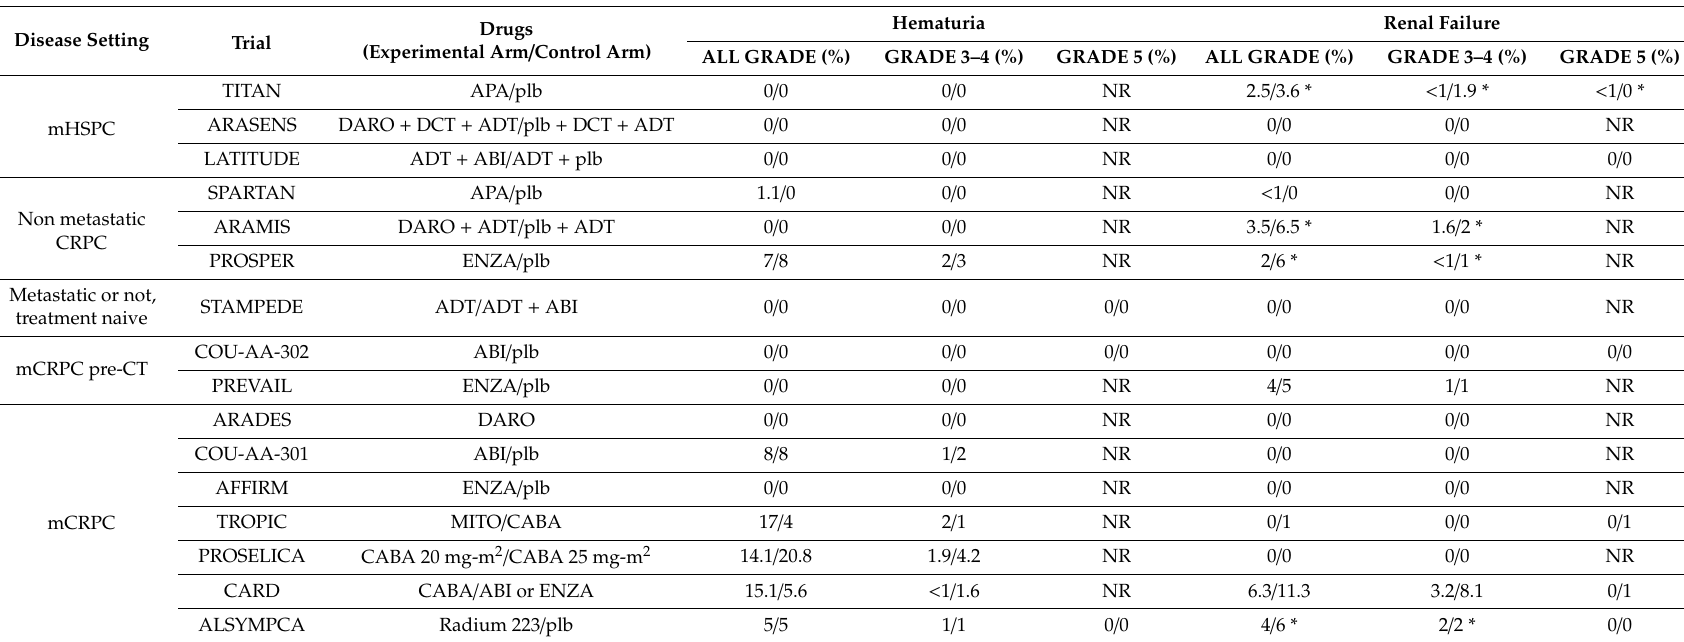
Table 3. Incidence of renal adverse events of new drugs for advance prostate cancer